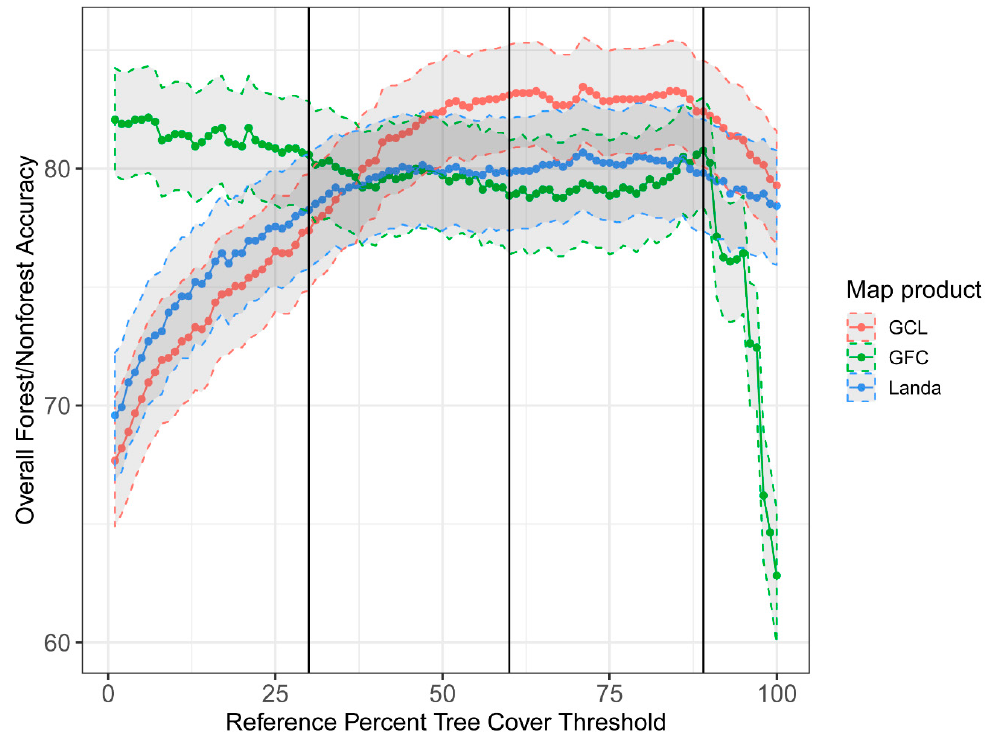
Figure 1. Overall accuracy at all possible reference data thresholds (1%–100% tree cover) for all forest/non-forest products. Connected points indicate overall accuracy, while dotted lines show 95% confidence intervals in overall accuracy estimates. Vertical lines show potential tree cover thresholds to define forest cover (30%, 60%, and 89%).